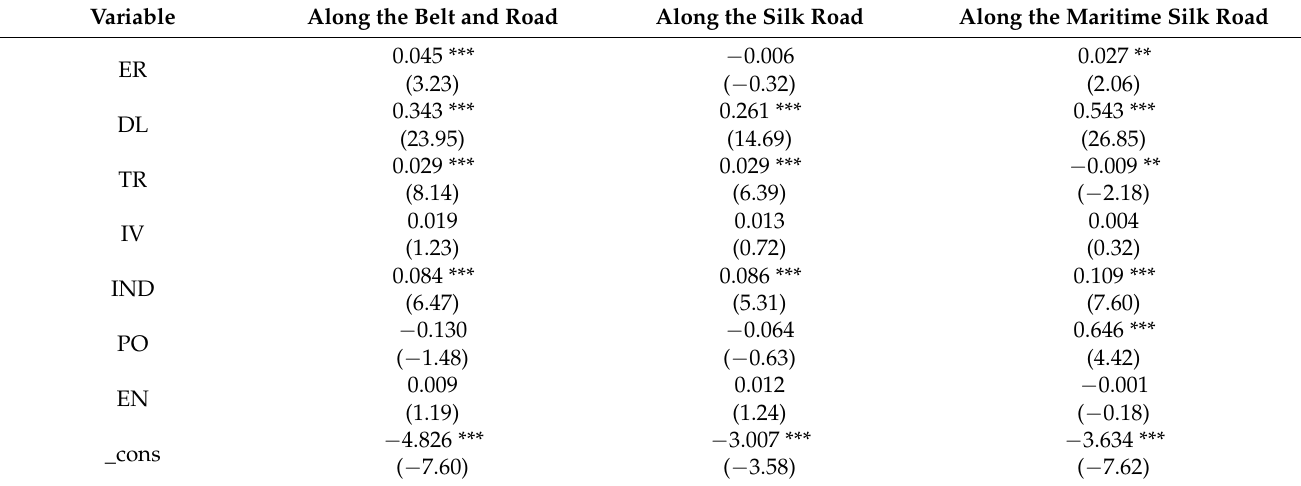
Table 3. Regression results of